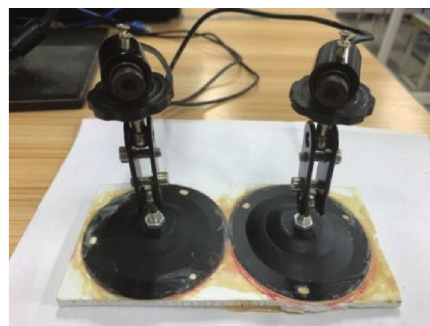
Figure 4: Laser transmitter in